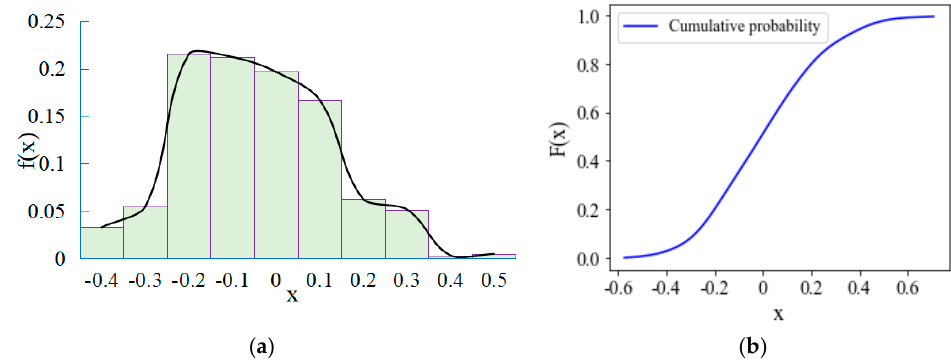
Figure 8. Fitting results of nonparametric regression (3000 MW − 3600 MW). ( a ) Error distribution histogram and probability density function. ( b ) Cumulative distribution function.